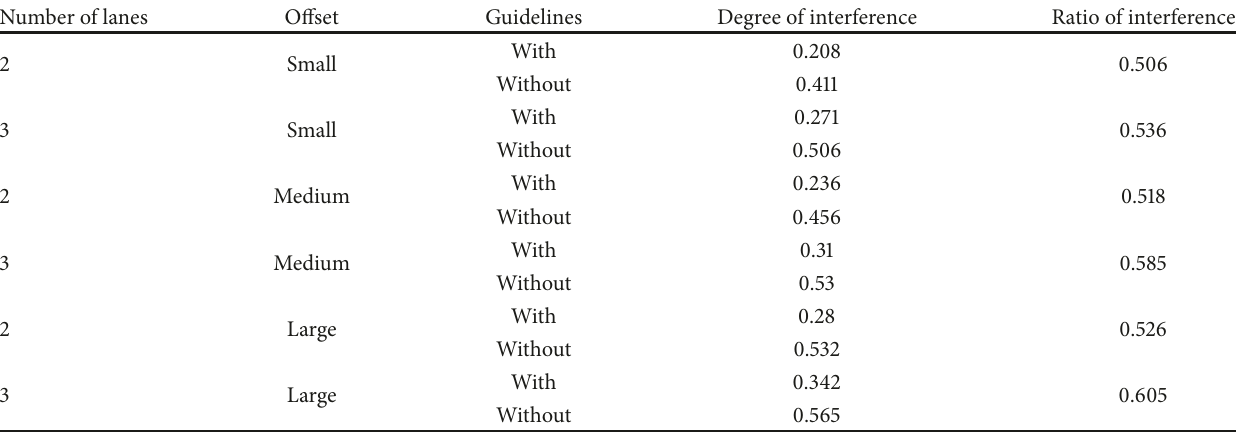
Table 8: Degree of interference for through movement.